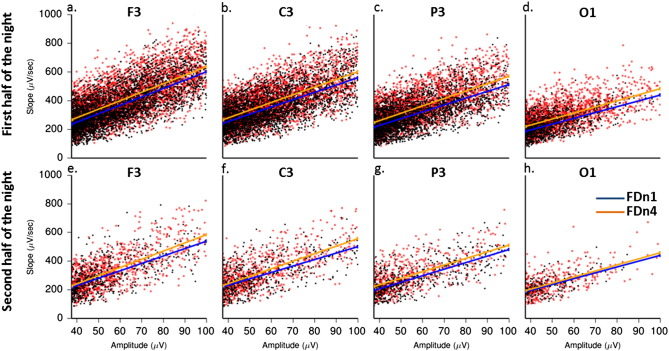
A representative example of the effect of sleep timing on the association between the absolute mean slope and the amplitude of the SWs during the first and second half of the sleep episode (BB0135, Female, 23 years).Fitted least square mean regression lines between the absolute mean slope and the amplitude of the SWs (negative half waves > 37.5 μV, absolute value) as measured during the first and the second half of the night when sleeping at habitual nocturnal bedtimes s (FDn1) and the sleep episode starting 12 h later, i.e. during the biological day (FDn4). The data show that when sleeping during the biological day, for any given amplitude the slope is greater, than when sleeping during the biological night.